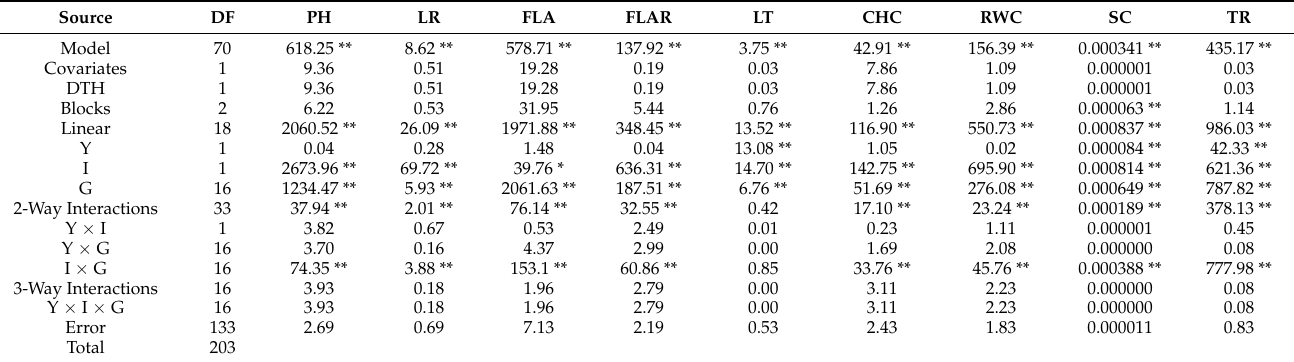
Table 4. Analysis of covariance for different morpho-physiological